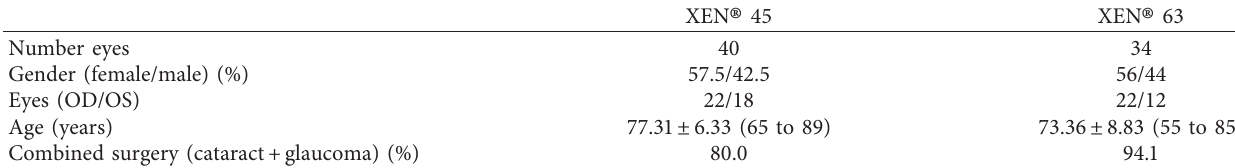
Table 1: Demographic data.